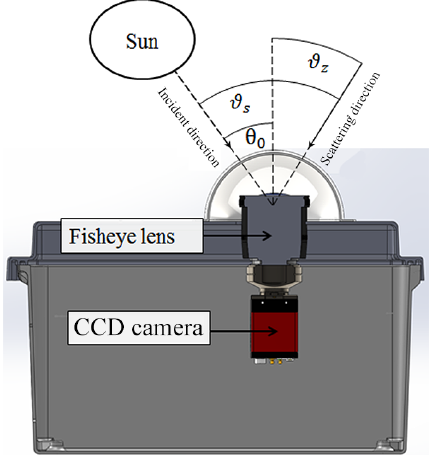
Figure 2. Diagram of the UCSD sky imager (USI) and related solar and sky geometries. θ 0 is the solar zenith angle. The ϑ s is the angle subtended by the vector pointing at the sun and the vector pointing at the pixel in question. The ϑ z is the angle formed by the vector pointing at the pixel in question and zenith. It is important to note that ϑ s = θ 0 + ϑ z only holds in 2-D but not in 3-D because the in- cident and scattering directions may not be in the same azimuthal plane. An example of this is illustrated in Fig. 3.